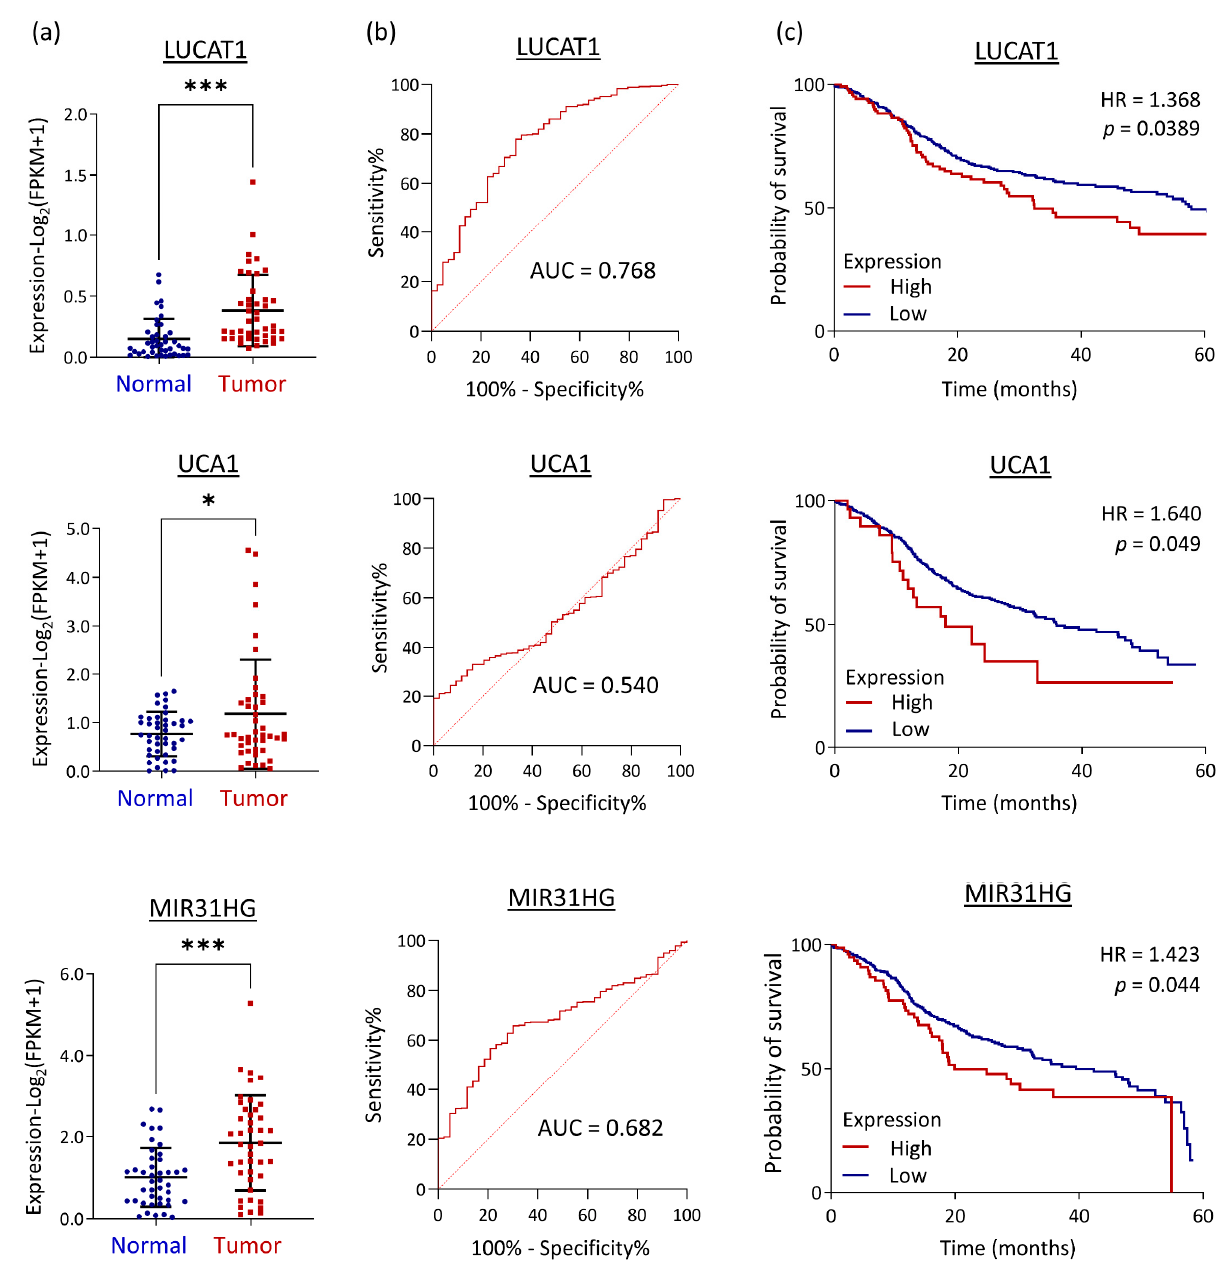
Figure 5. Clinical significance of LUCAT1, UCA1, and MIR31HG in HNC, as assessed by TCGA- HNSC dataset with paired tumor and normal tissues. ( a ) Differential expression levels of LUCAT1, UCA1, and MIR31HG between 43 paired normal and tumor tissues, as determined by paired t -test. ( b ) The ROC curves and the AUC values show the diagnostic efficacy of LUCAT1, UCA1, and MIR31HG for HNC using complete TCGA-HNSC dataset. ( c ) Prognostic significance of LUCAT1, UCA1, and MIR31HG for HNC, as demonstrated by the p -values and hazard ratios (HRs) via Kaplan-Meier analysis with complete TCGA-HNSC dataset (n = 500). (*: p < 0.05, ***: p <